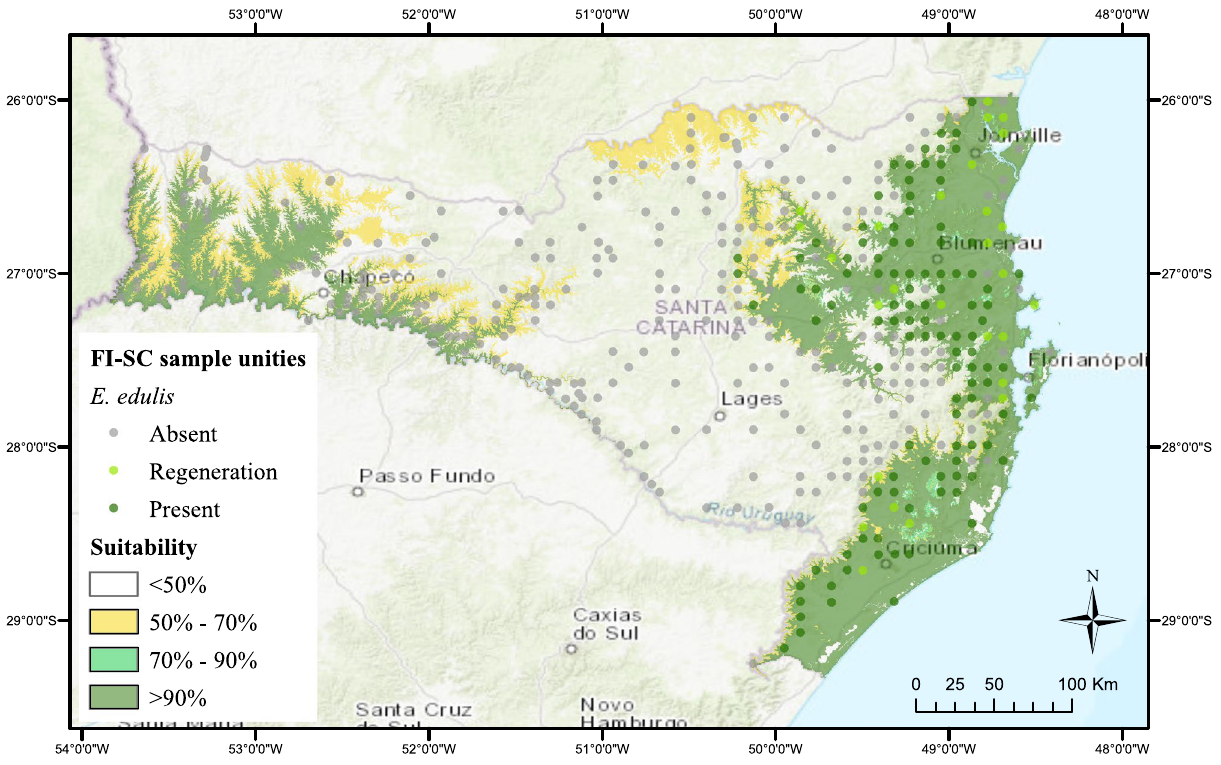
Figure 3. Spatial distribution of the Floristic Forest Inventory of Santa Catarina sampling units with E. edulis by